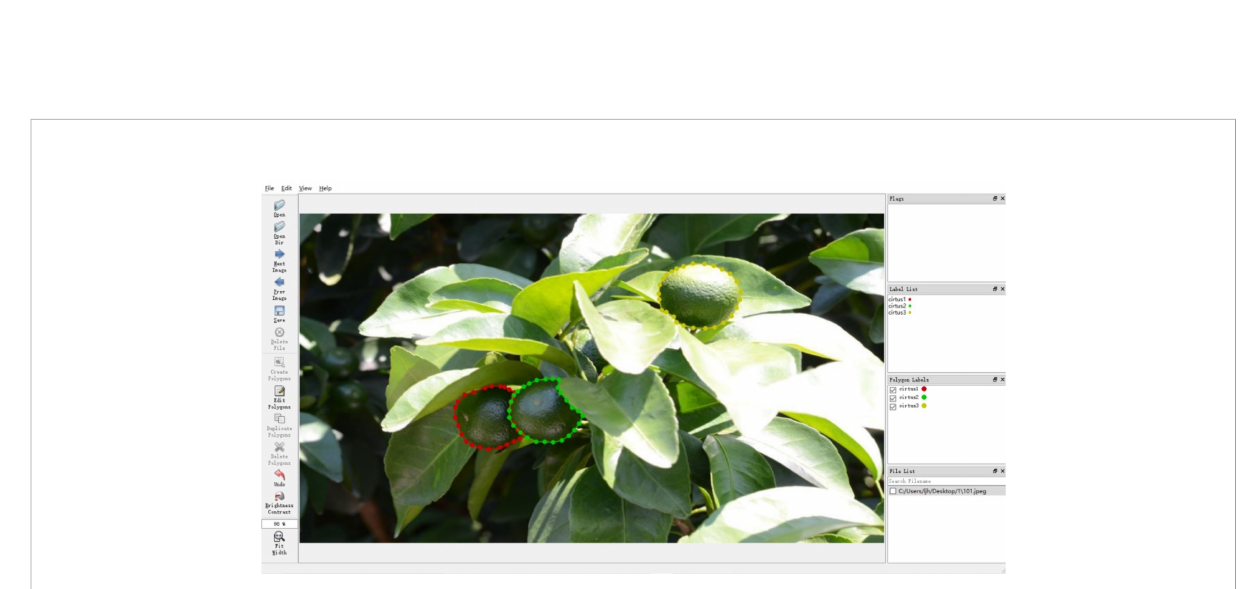
FIGURE 4 Data annotation